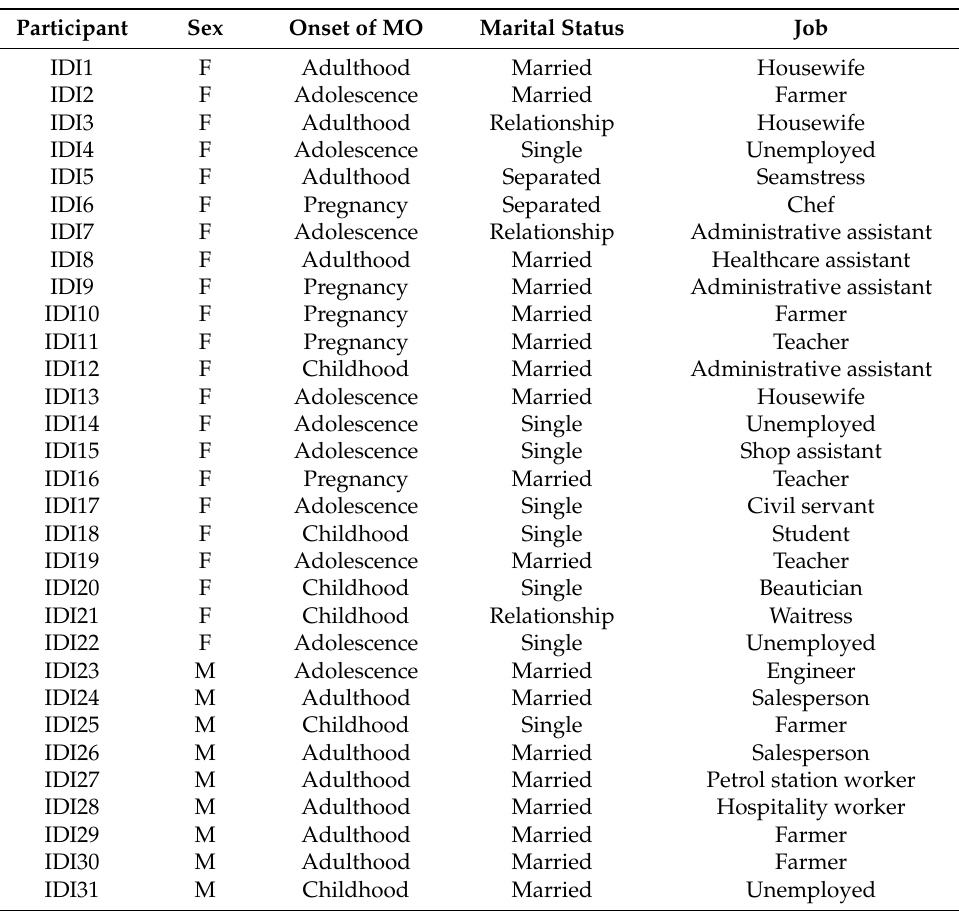
Table 1. Sociodemographic